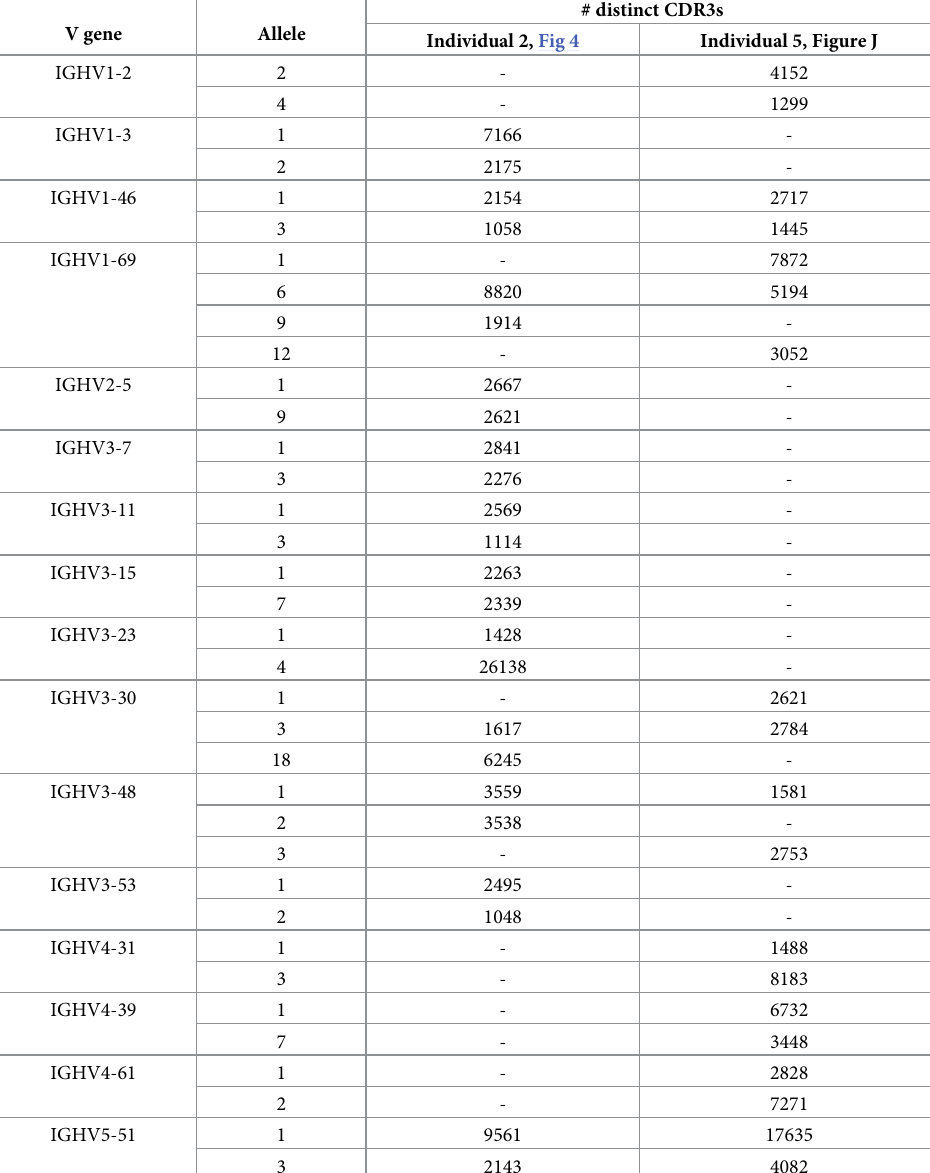
Table 6. Abundant heterozygous IGHV genes in individual 2 from Healthy PBMC datasets (Fig 4) and individual 5 from the Intestinal datasets (Figure J). For individual 2, only the IgM datasets were used. For individual 5, only the naive datasets were used. V gene Allele Individual 2, Fig